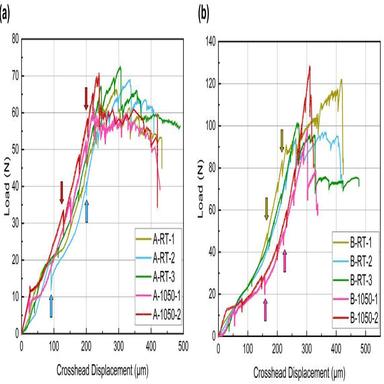
(a)-(b) Load vs. crosshead displacement for materials A and B, respectively. The coloured arrows indicate locations of XCT scans and the associated load relaxations.